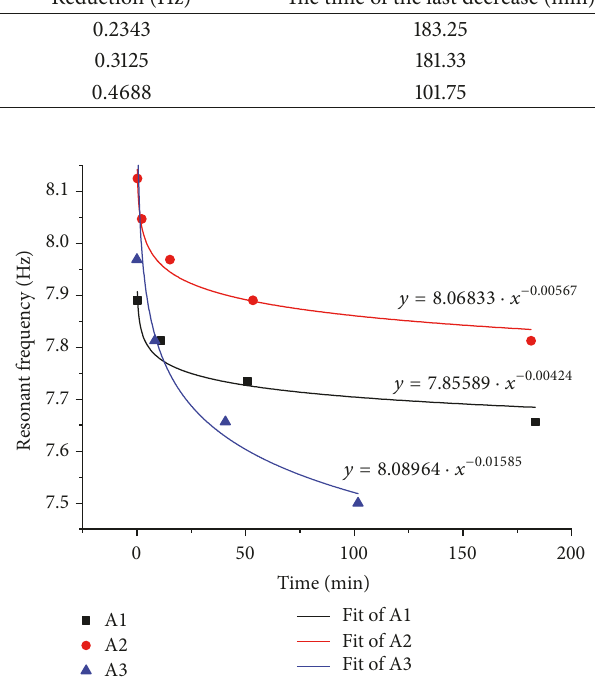
Figure 17: The variation and fitting curves of resonant frequency in Group